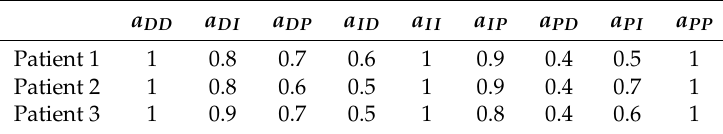
Table 2. Competition coefficients for different patient types.